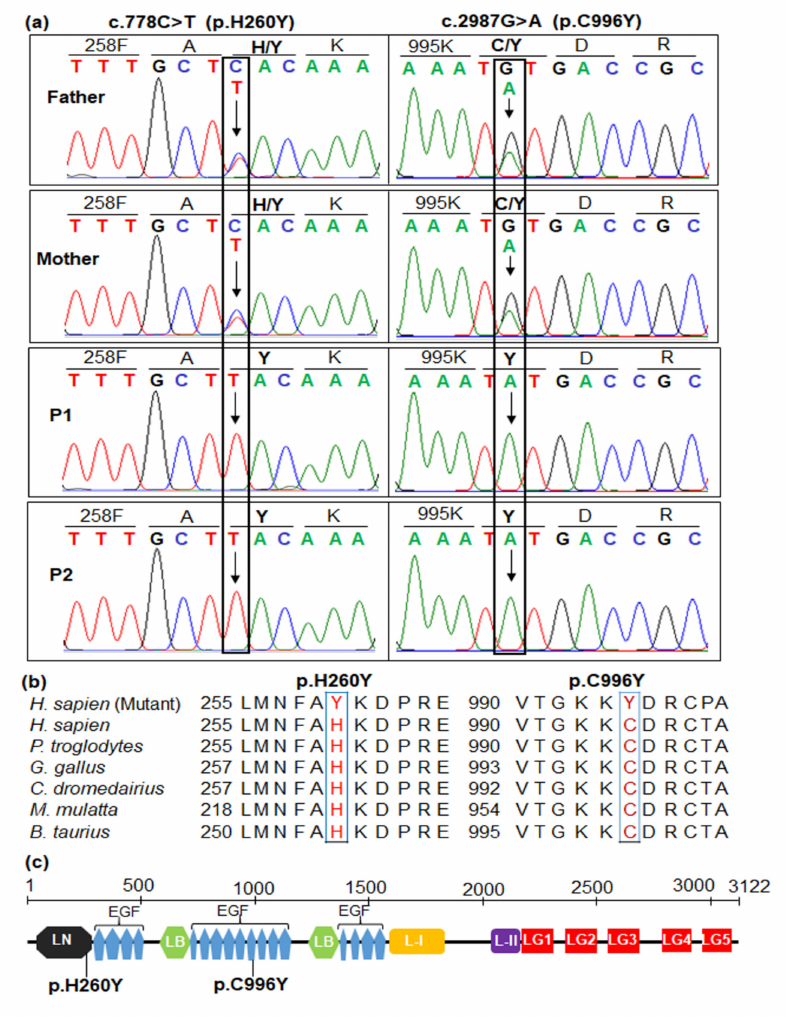
Figure 2. Sanger sequencing validation for two LAMA2 variants in the family ( a ). Patients P1 (proband) and P2 (younger sister) carried two missense variants, c.778C > T in exon 5 and c.2987G > A in exon 21, of the LAMA2 gene, in the homozygous state. These variants were inherited from their parents who carried those in the heterozygous state. ( b ) Evolutionary conservation of p.H260Y and p.C996Y. Amino acid alignments indicated that H260 and C996 are highly conserved across species. ( c ) Location of the two variants in LAMA2 protein. LAMA2 includes laminin N-terminal (LN, black hexagon), 17 laminin epidermal growth factor (EGF)-like domains (EGF, blue pentagons), 2 laminin B (LB, light green hexagons), laminin I (I, brown rectangle), laminin II (II, purple rectangle), and 5 laminin globular (LG, red rectangles) (https: // pfam.xfam.org / protein / P24043). LAMA2 p.H260Y is mapped in the laminin N-terminal and p.C996Y located in the laminin